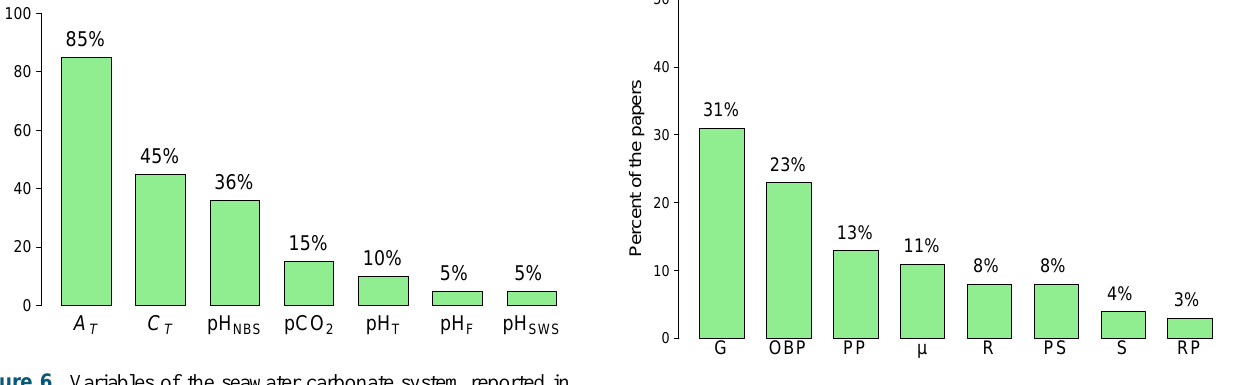
Figure 7. Biological processes reported in the papers: G, calcifica- tion rate; OBP, other biological variables; PP, primary production; µ , growth rate; R, respiration; PS, photosynthesis; RP, reproductive processes; and S, survival.